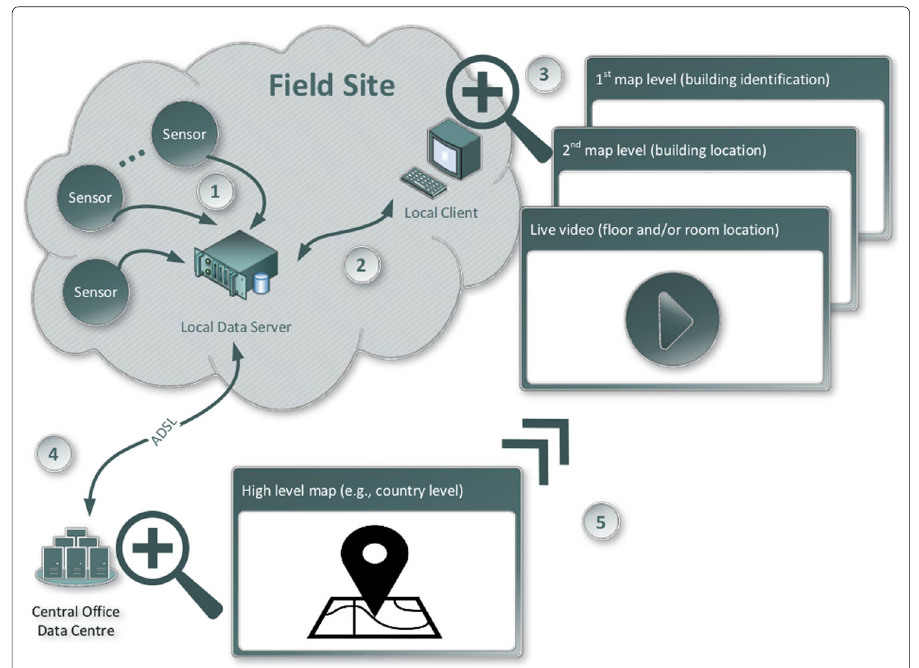
Fig. 2 Advanced surveillance architecture for utility